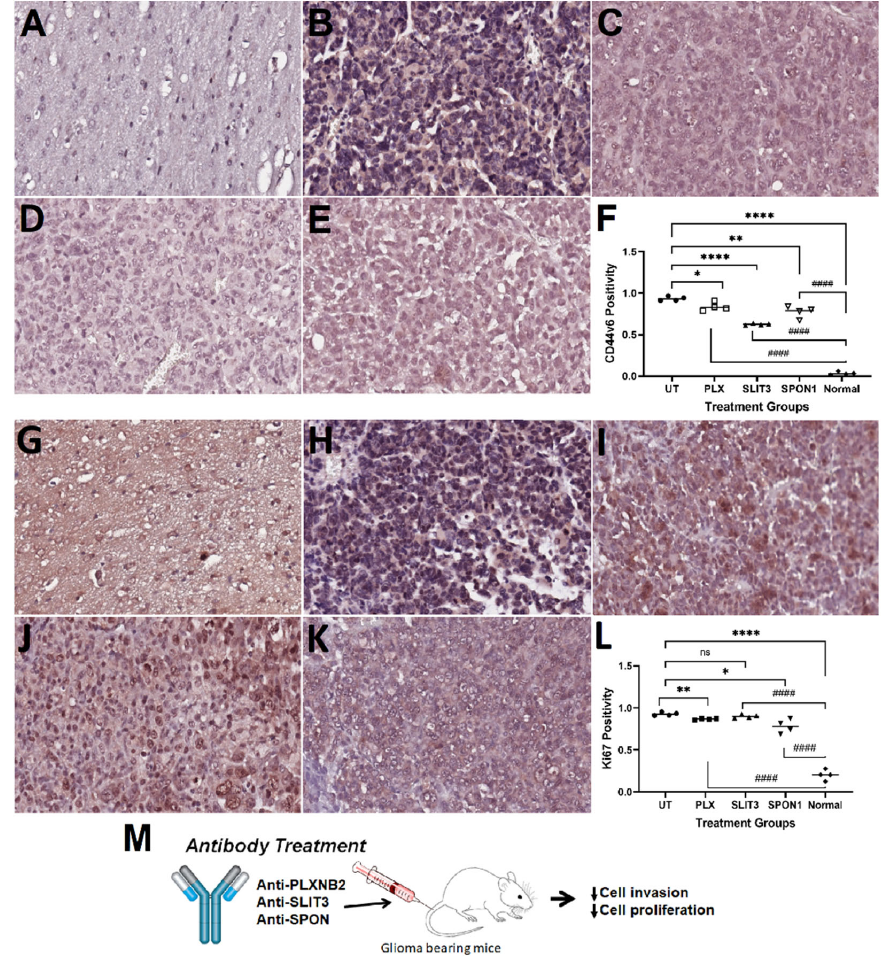
Figure 4. Immunohistochemistry (IHC) staining for CD44v6 in normal ( A ), untreated (UT) ( B ), and antibody treatments targeting plexin ‐ B2 (PLX) ( C ), SLIT ‐ 3 (SLIT3) ( D ), and SPON ‐ 1 (SPON1) ( E ).